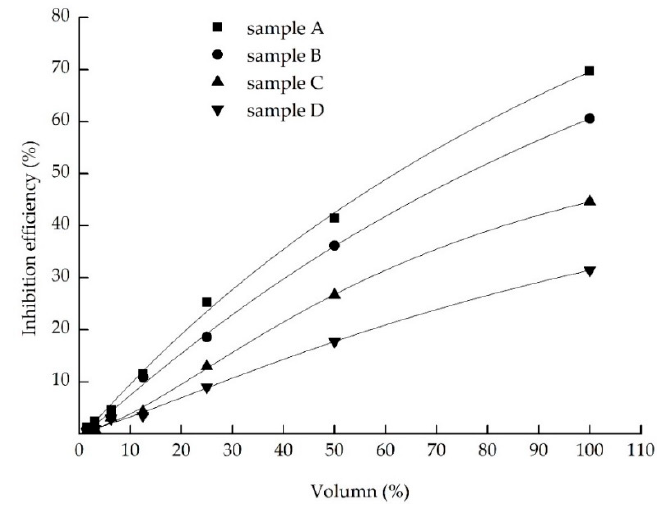
Figure 3. Dose-response relationship of four treatment process effluents on the Vibrio fischeri toxicity. sample A, coagulation and sedimentation tank effluent; sample B, anaerobic tank effluent; sample C, electrochemical oxidation tank effluent; and sample D, aerobic tank effluent.